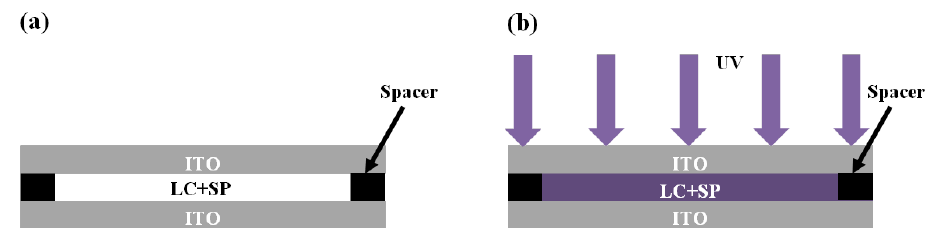
Figure 3. (a) Scheme of the cell structure composed of 200nm ITO and 20μm spacer when the LC/SP mixture was injected into the cell. (b) Cell schematic when sample is irradiated by UV and where the electric properties of the LC/SP mixture are measured using an impedance analyzer (Agilent 4294A).